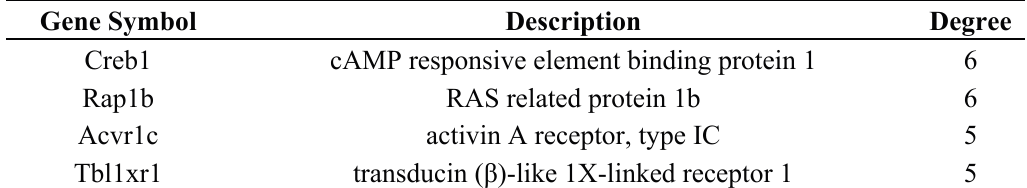
Figure 7. The miRNA-gene-network of the specified miRNAs. The squares indicate the miRNA, while red indicates the up-regulated miRNAs, and green indicates the down-regulated miRNAs. Table 2. The genes regulated by miRNAs with degrees above